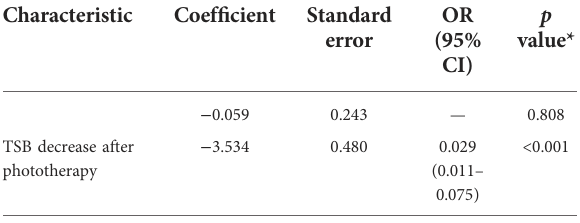
TABLE 6 Model 3 created with TSB decrease after phototherapy and phototherapy outcome.